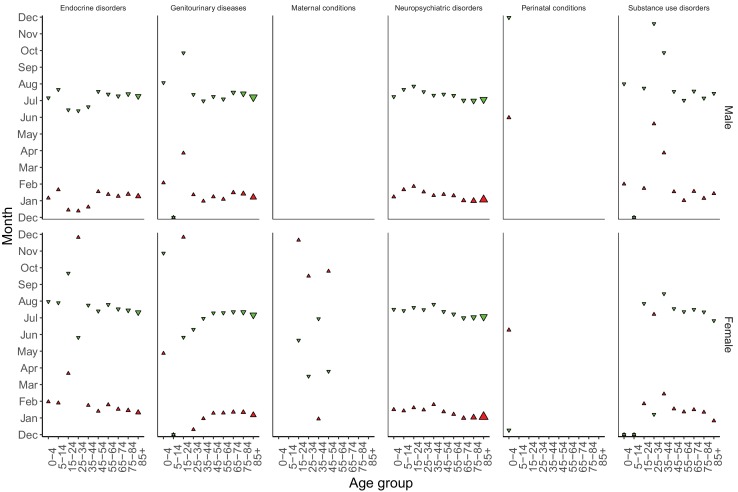
Mean timing of maximum and minimum mortality for the cluster of causes other than cancers, cardiorespiratory diseases and injuries at the national level, by sex and age group for 1980–2016.Red arrows indicate the month of maximum mortality, and green arrows that of minimum mortality. The size of the arrow is inversely proportional to its respective variance.